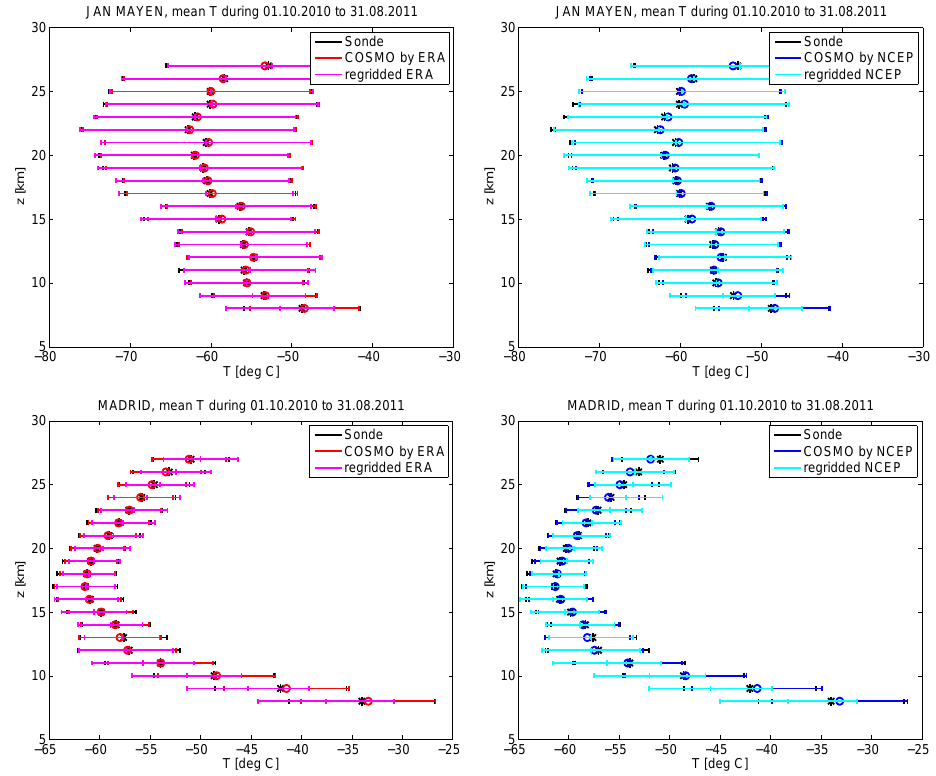
Figure 6. Mean temperature values at each height for the station on Jan Mayen, station no. 20, on the top, and for Madrid, station no. 1, on the bottom, showing results of the run forced by ERA-Interim (left) and NCEP (right). The horizontal lines give the 1 σ standard